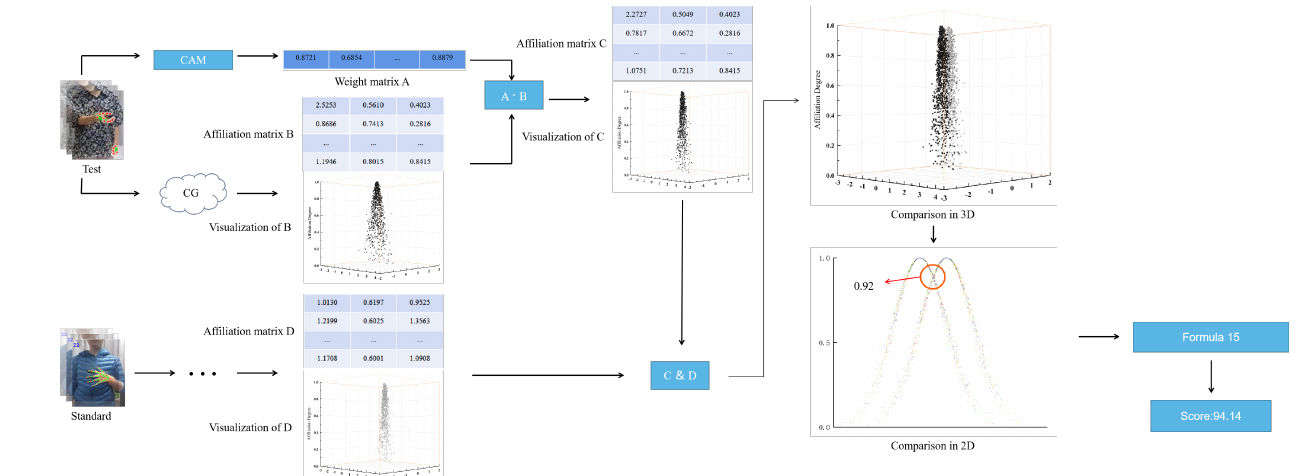
Figure 6. Evaluation process of wearing insulated gloves.